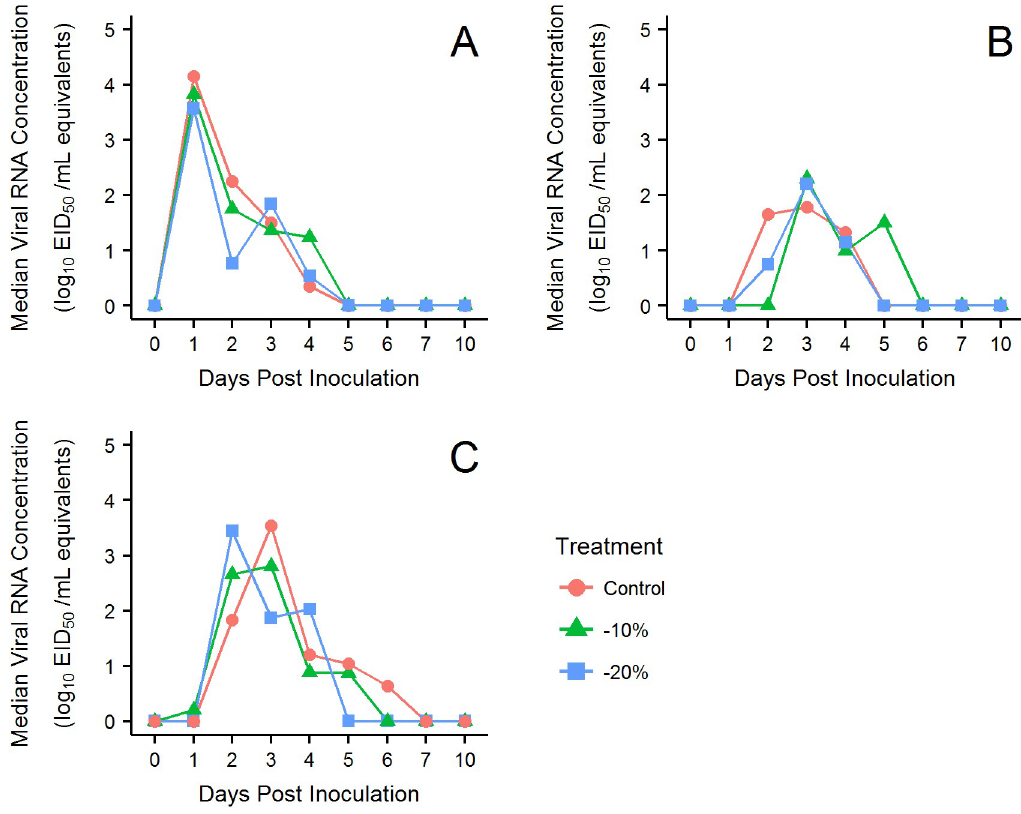
Fig 3. PCR Results. Line plots of median viral RNA concentrations. The areas under the curves are indexes for the total amount of virus detected across the infection. (A) oral swabs, (B) cloacalswabs, and (C) fecal